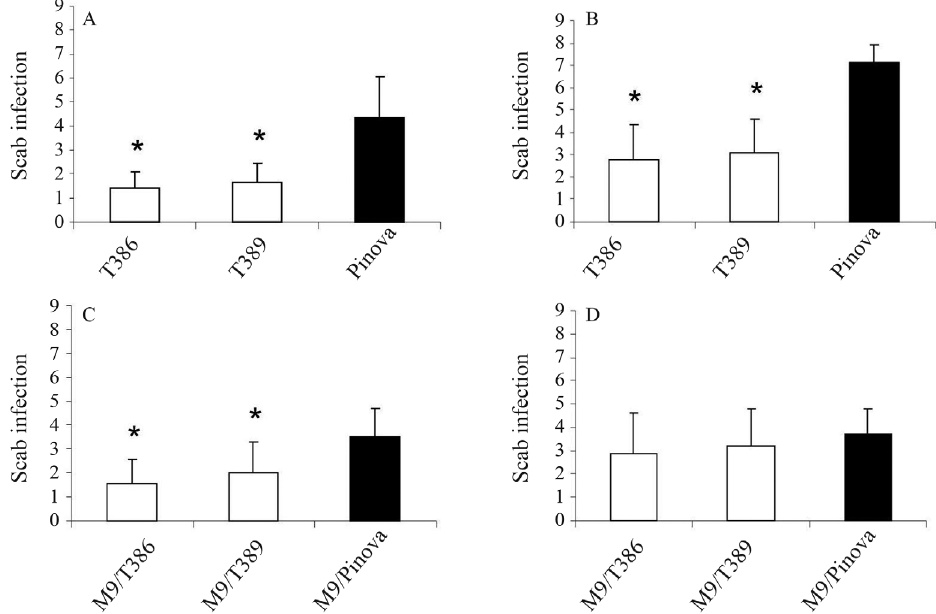
Figure 5 - Scab susceptibility tests against V. inaequalis in non-transgenic Pinova and transgenic lines T386 and T389 on own roots (non-grafted) 17 (A) and 28 (B) days post-inoculation (dpi) and scions of non-transgenic control Pinova and transgenic apple clones T386 and T389 grafted onto the non-transgenic rootstock M9 at 17 (C) and 28 (D) dpi. Shoot regrowth was inoculated with a local mixture of scab conidia (10 5 conidia/mL). The degree of scab infection on infected leaves was scored on a scale of 1 to 9 after 17 (A) and 28 days (B). The results of different shoots from each clone were aver- aged. The columns represent the mean (cid:3) SD of 20-29 determinations. Significance (*p < 0.05) was detected using Dunnett’s t